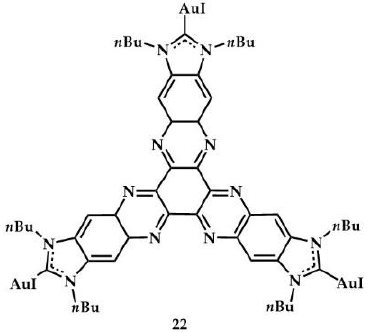
Figure 9. Gold complex with hexaazatriphenylene core.